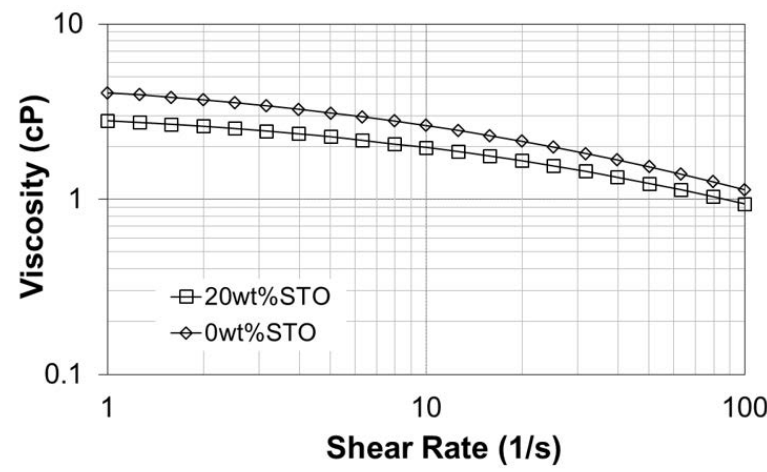
Figure 22. Viscosity study of bio-composites made with 15 v% cellulose containing 0 wt. % STO and 20 wt. % STO